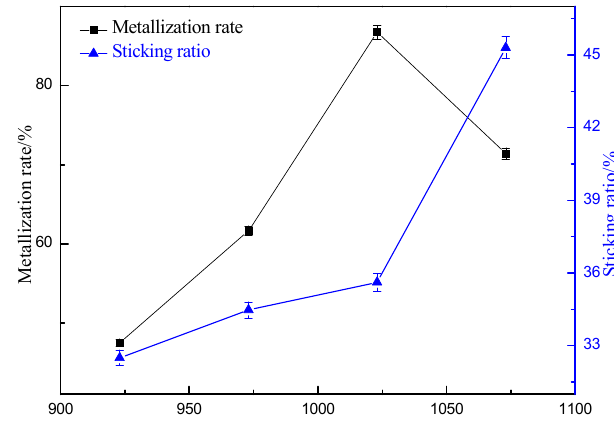
Figure 5. Trend of the metallization rate and sticking ratio with changing temperature when 0.18 mm–0.66 mm of OMC fine iron ore is reduced by pure carbon monoxide at 0.2 MPa, 0.8 m/s after 35 min.